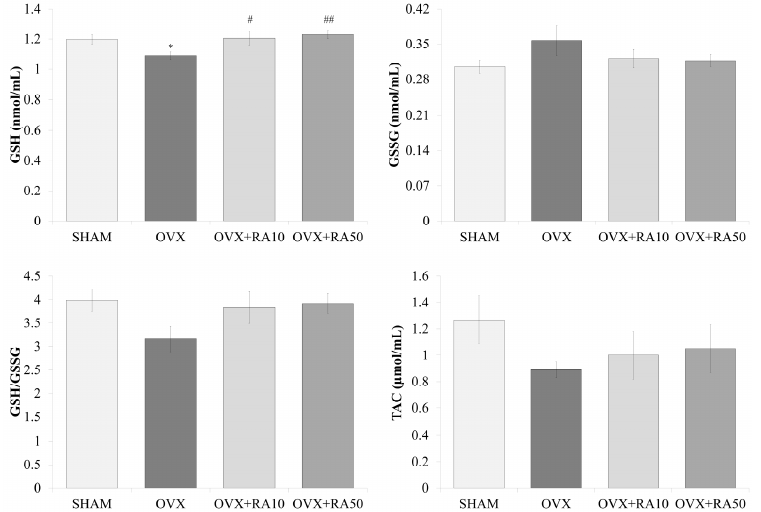
Figure 4. Effect of rosmarinic acid on the serum concentrations of reduced glutathione (GSH), oxidized glutathione (GSSG), GSH/GSSG ratio and total antioxidant capacity (TAC). Rosmarinic acid at doses of